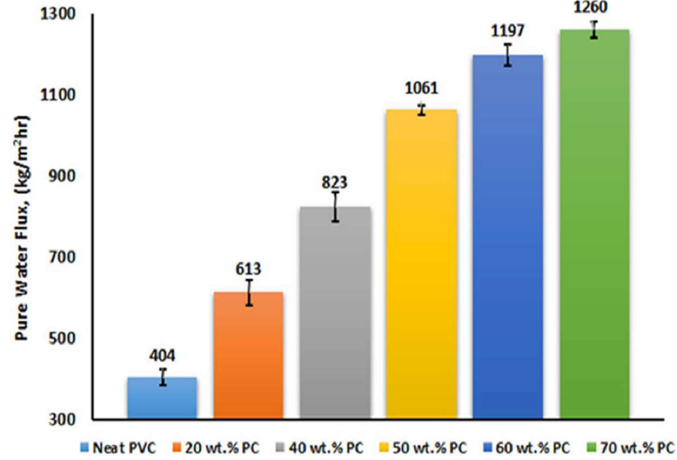
Figure 1. Water flux of polymer blend membranes (reproduced with permission from [22] copyright 2017, Elsevier).